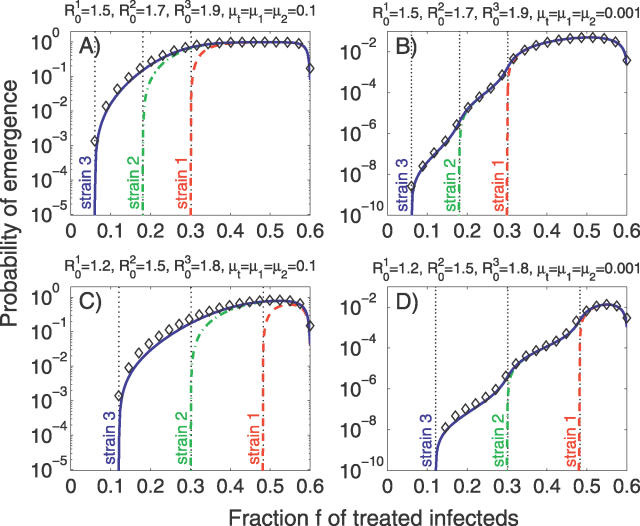
Probability That Resistance Emerges within One YearThe black diamonds show the probability that any one of the resistant strains emerges (reaches a level of 5% of total infecteds), obtained from stochastic simulations of the full system (stochastic version of Equation 1). The red dashed, green dash-dotted, and blue solid lines show the analytic result (Equation 9 with τ =1). The vertical black lines indicate the level of treatment at which the fitness of the respective resistant strain is the same as that of the sensitive strain. Parameters are chosen as in Figure 4.